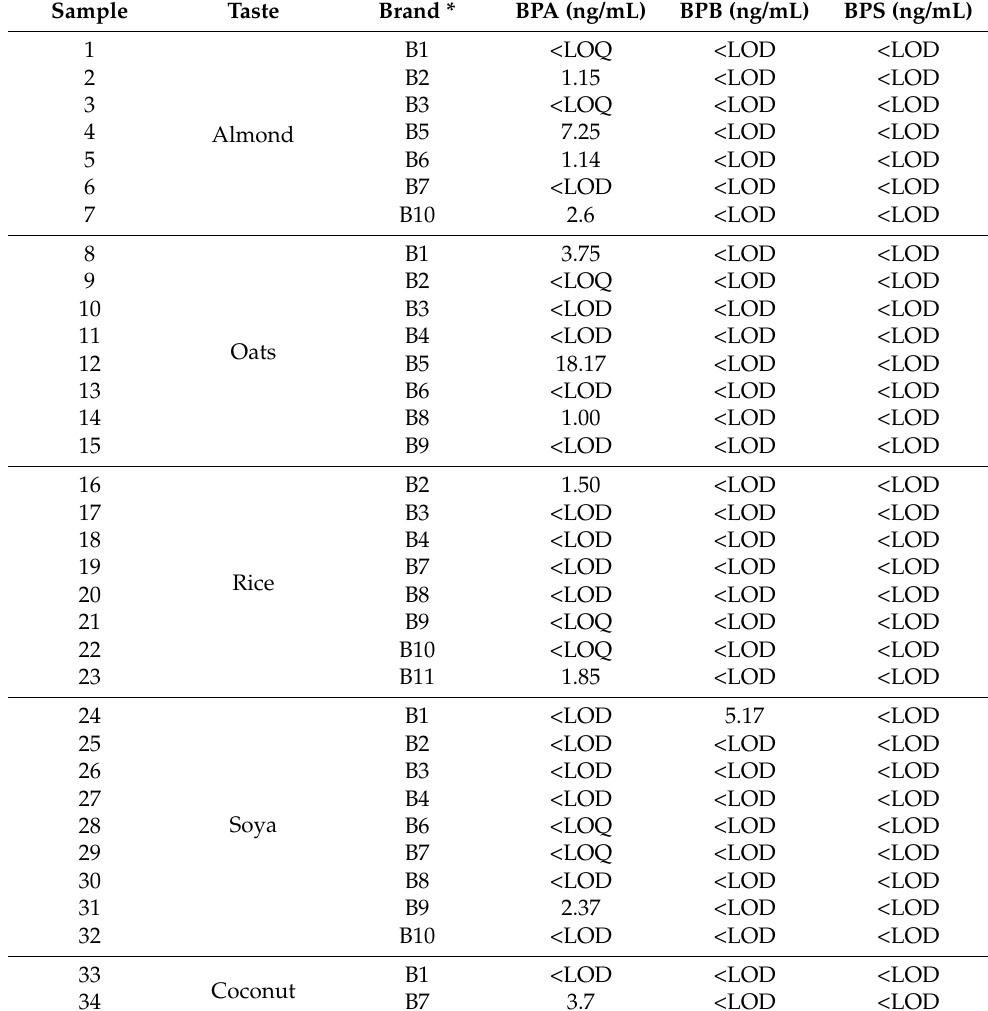
Table 4. Bisphenol contamination level in 34 plant-based beverages collected from Italian